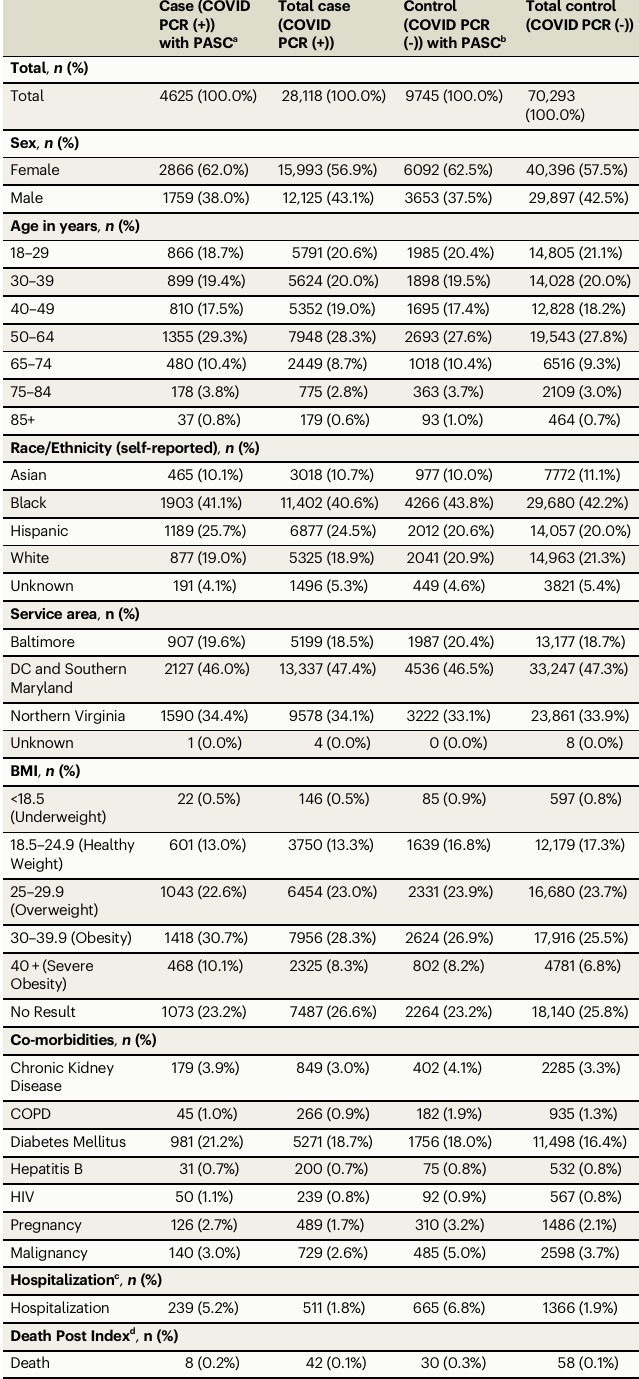
Table 5 | Patient demographics for the matched cohort vs patients experiencing PASC related conditions Case(COVID PCR (+)) with PASC